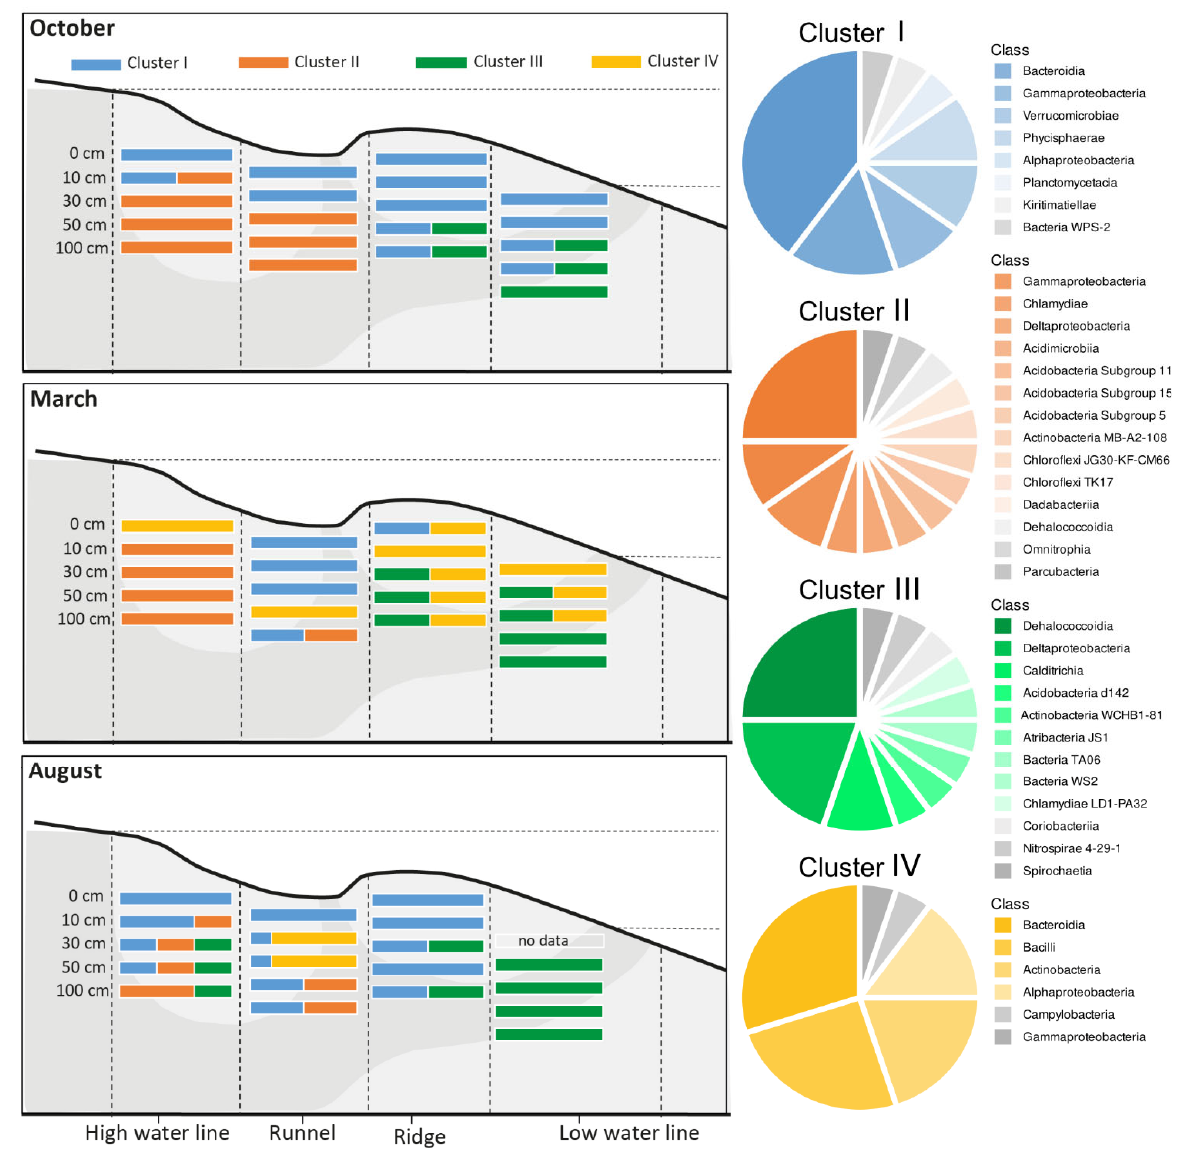
Figure 1. The spatial and temporal distribution of the four clusters based on their relative abundances within the Illumina dataset. The pie charts depict the 20 most representative classes of each cluster based on the respective IndVals. A NMDS visualizing the taxonomic relationship between the cluster can be found in the Supplementary Figure S1.